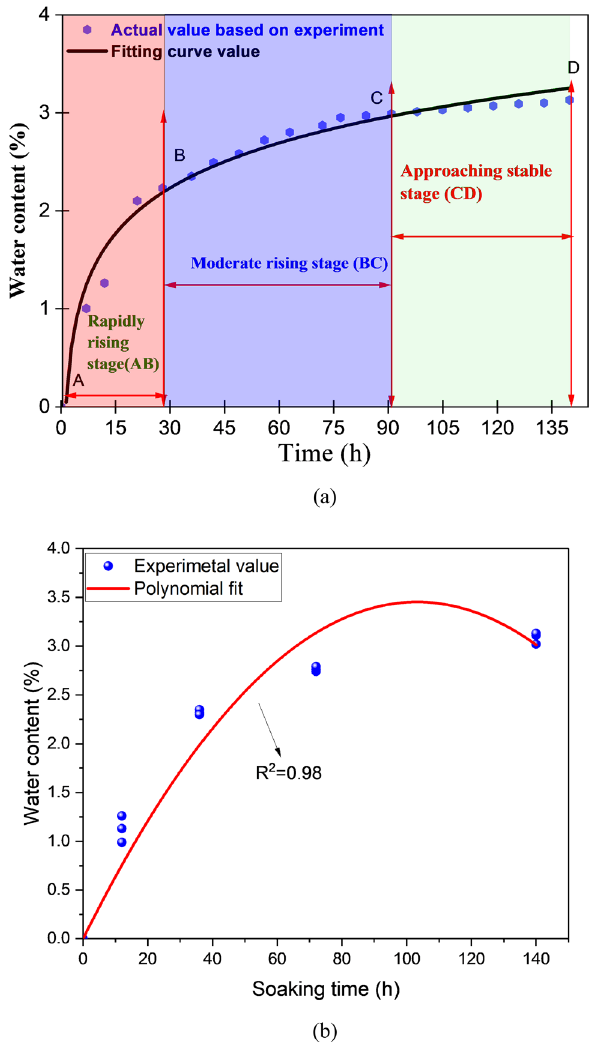
Figure 2. The relationship between soaking time and water content based on ( a ) saturation process ( b ) samples selected for